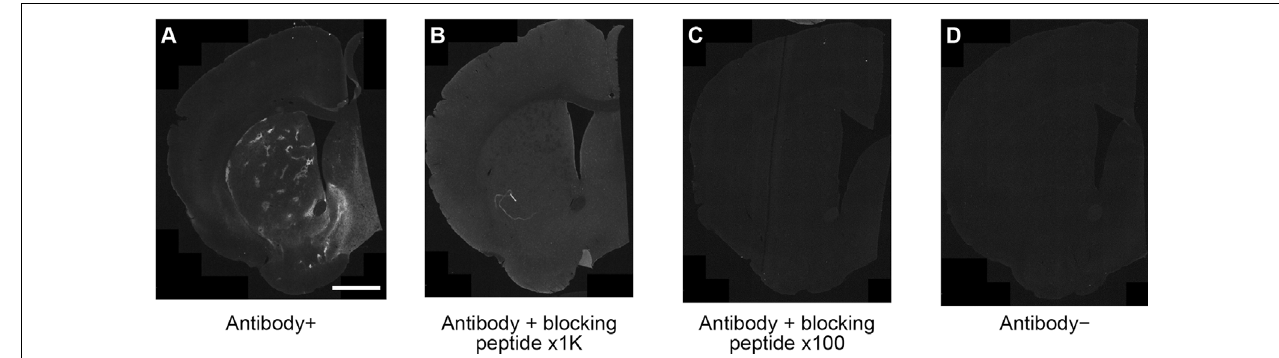
FIGURE 3 | An immunizing peptide blocking assay. In comparison with positive control staining with anti-MOR1 antibody (A) , the labeling of MOR1 was blocked when the primary antibody was preabsorbed with 0.05 µ g/ml (B) and 0.5 µ g/ml (C) MOR1 peptide antigen. Note that the pre-absorption with high-dose peptide antigen (C) completely blocked MOR1 labeling equivalent to the level of negative control staining (D) . Raw images were inverted, subtracted from their background, and filtered by using Fiji software. Scale bar = 1 mm.